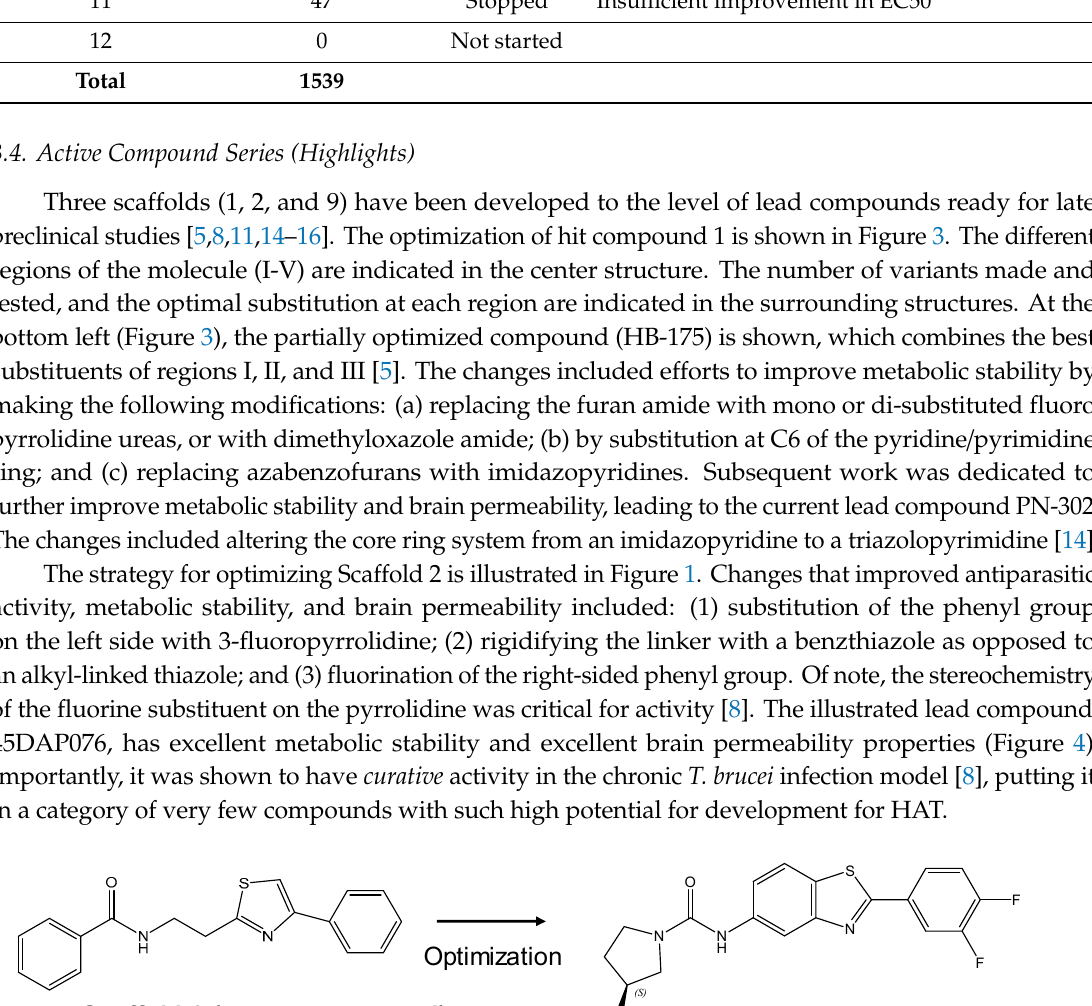
Figure 5. Scaffold 9: Optimization of hit “thiohydantoin” compound to lead compound BA-738. 4. Discussion This paper summarizes the results of a drug discovery campaign to identify preclinical candidates for HAT starting from a phenotypic screen. Detailed results relating to four of the scaffolds have been published (see references in Table 2), but an overview of the general strategy and complete results has not been previously reported. Some helpful points can be learned by studying the failed scaffolds as well as by studying the successful ones. As indicated, 17 compounds representing distinct scaffolds (Table 1) were selected from the original hit list of 1035 compounds. By definition, these compounds had activity against T. brucei cells and thus demonstrated sufficient cell permeability to reach intracellular targets. This feature of the cell-based screen provided a theoretical advantage over biochemical (acellular) screens where hit compounds subsequently have to be tested for (and perhaps optimized for) cell permeability properties. Similarly, the screening protocol included a counter screen against mammalian cells that eliminated compounds with cytotoxicity. A whole-cell cytotoxicity assay identified any type of cellular toxicity and thus was broader than a counter screen against, for example, a mammalian homolog in an enzymatic screen. Thus, these features illustrate the potential advantages of phenotypic screens over target-based screening with the acknowledged disadvantage that the target of activity is unknown. As a result, the hit-to-lead optimization was done agnostically to the target. For most of the project, we chose not to divert time and resources to the effort of target identification. Hit-to-lead chemical optimization was done using standard medicinal chemistry approaches without guidance from protein crystal structures. The target of compound series 1 (the trypanosome proteasome) has subsequently been identified [18], but this did not contribute to designing or synthesizing the current lead compounds (Figure 3). The results of the program to-date are that three of 11 scaffolds (27%) have been optimized to the point of giving cures in the murine model of T. brucei infection. More work needs to be done before compounds are brought to clinical trials, but the output of this campaign shows strong promise for delivering clinical candidates, particularly when compared to the results of target-based screening efforts